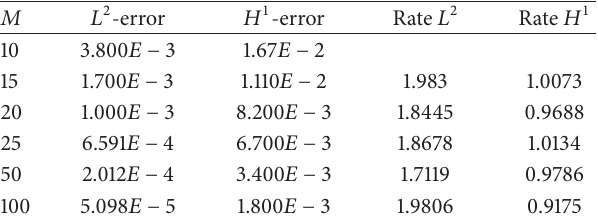
Table 1: NSFD method error in both 𝐿 2 and 𝐻 1 -norms.